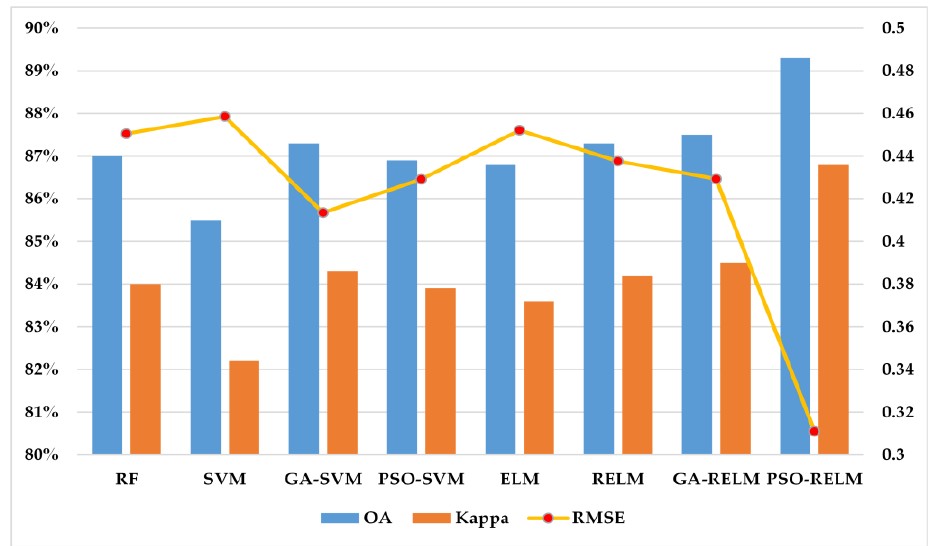
Figure 11. Overall evaluation metrics of the testing samples in the Z1 area.